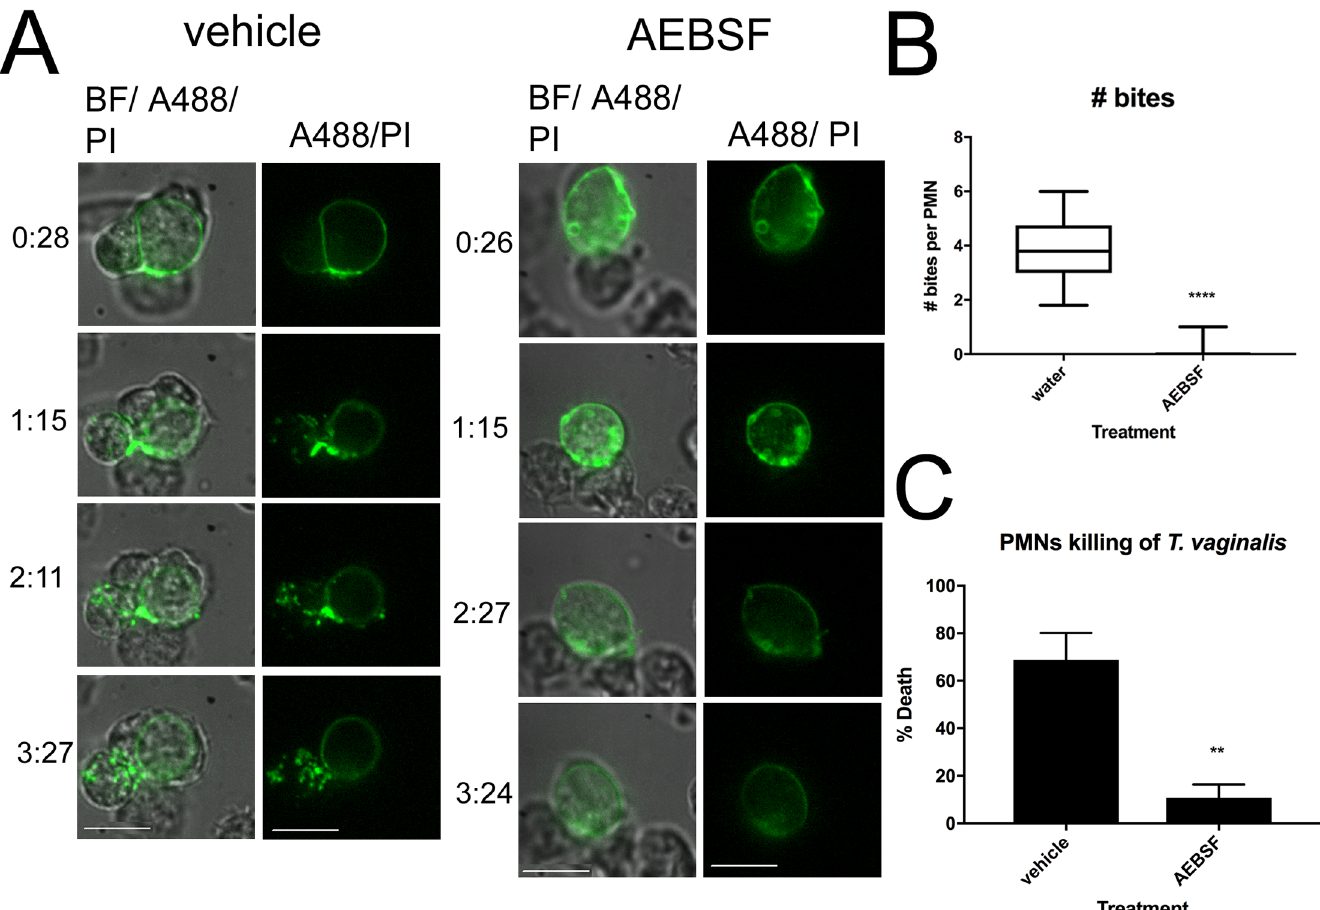
Fig 5. Serine proteases are required for trogocytosis and killing of T . vaginalis . (A) Live imaging was performed identical to that in Fig 4A, except for the pre- incubation of PMNs either with water (vehicle control) or 1-mM AEBSF for 20 minutes prior to addition of parasites. Scale bar = 10 um. (B) Videos of at least 3 parasites bound to PMNs, chosen at random from 3 donors’ PMNs each were analyzed for the number of “bites” of T . vaginalis material transferred to PMNs before parasite death, in the presence of vehicle or 1-mM AEBSF, which were pre-incubated with PMNs for 20 minutes before addition of parasites. The number of bites observed was divided by the number of PMNs present in the swarm, in each case. Total number of parasites analyzed was 15 in the vehicle group and 21 in AEBSF. (C) PMN killing of T . vaginalis at MOI 0.125 (same MOI as panels A and B) was determined using the flow cytometry–based cytolysis assay, in the presence of vehicle or 1-mM AEBSF. Data are represented as mean ± SD of triplicate wells and representative of 3 donors and 3 independent experiments. Underlying data can be found in S1 Data. BF, bright field; MOI, multiplicity of infection; PI, Propidium Iodide; PMN, polymorphonuclear